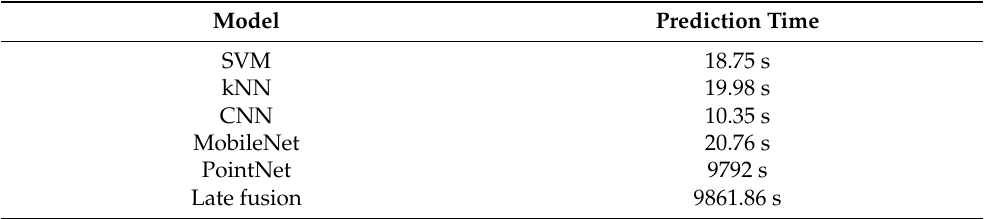
Table 4. Time-consuming comparison of various classification